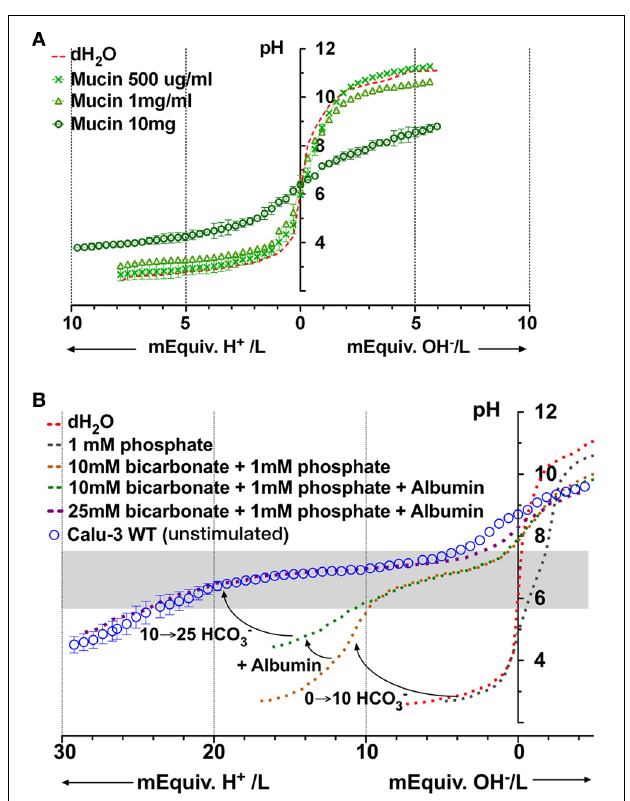
FIGURE 7 | Microtitration curves for porcine gastric mucins and simulation of Calu-3 fluid buffer capacity using individual components. (A) Buffering by different concentrations of mucin. (B) Simulation of Calu-3 by mixtures of PO = 4 , HCO − 3 , and albumin. Curved arrows show the effect of adding 10mM HCO − 3 , 10mg/ml albumin, and raising the concentration of HCO − 3 to 25mM. The gray rectangle represents the region between the stationary points of the